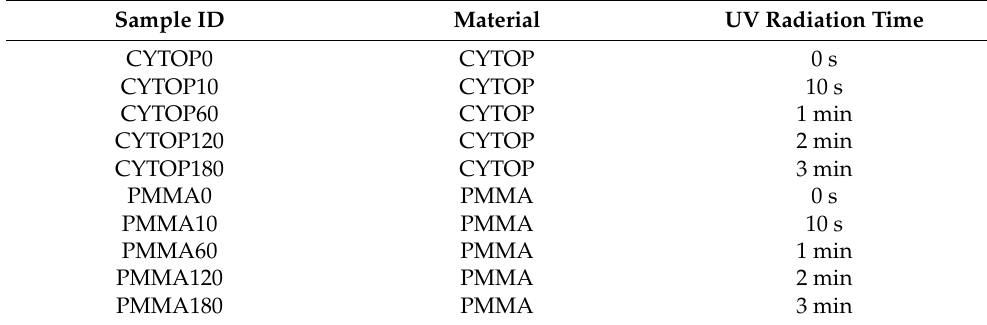
Table 1. Samples’ material and UV radiation